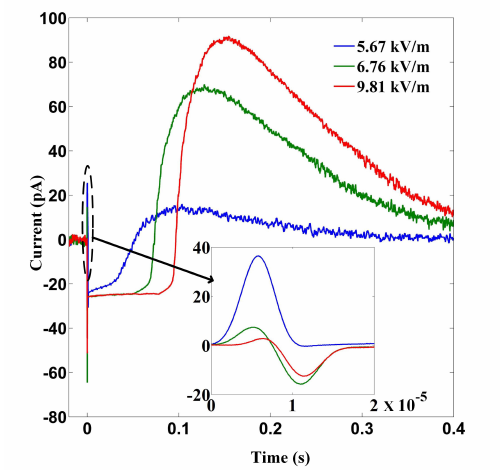
Figure 4. Electric currents between the two film electrodes inferred from the data shown in Figure 3a and Equation (3). The gain of the amplifier is devided when calculating the currents.